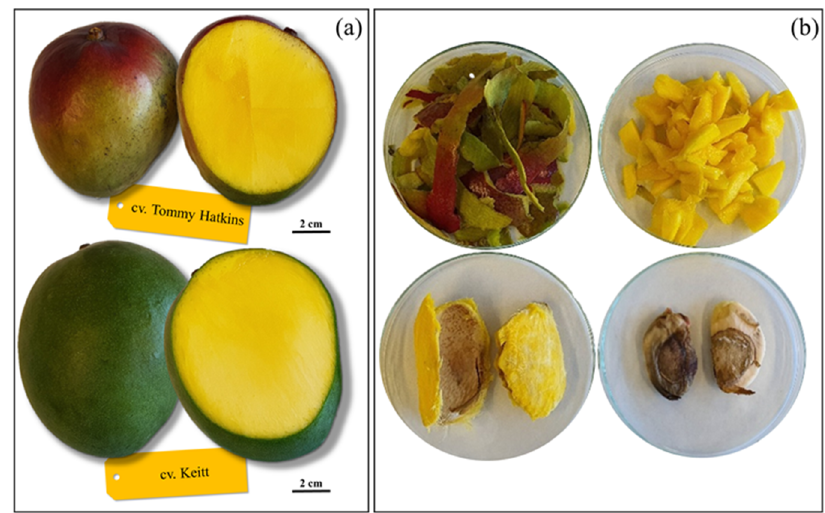
Figure 2. ( a ) External appearance and longitudinal sections of ripe fruits of Tommy Atkins and Keitt cultivars. ( b ) Macroscopic appearance of the peels, pulp and kernels isolated from representative fruits (Tommy Atkins cultivar).